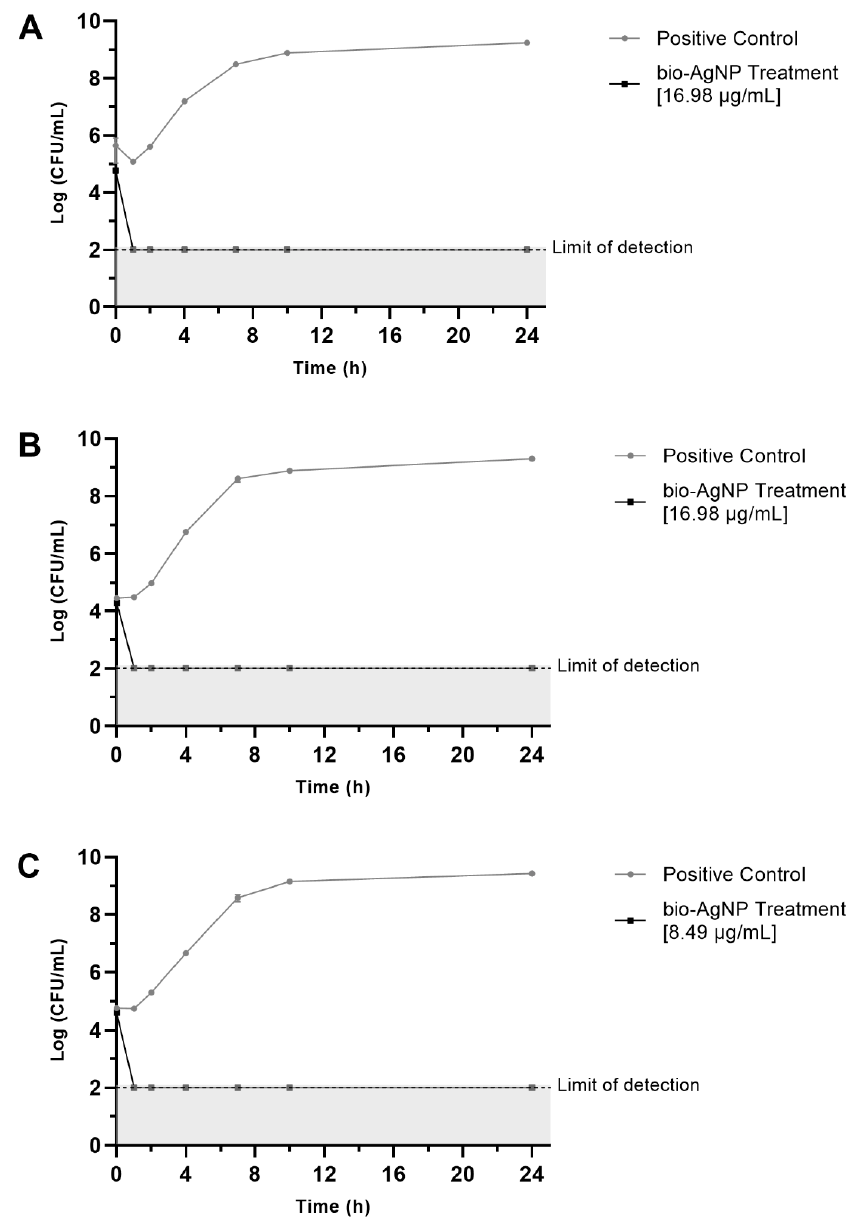
Figure 2. Time-kill curves of bacteria exposed to bio-AgNPs. Positive Control indicates bacterial growth without bio-AgNPs. The data are expressed as the mean ± standard deviation of three repli- cates. ( A ) S. Enteritidis ATCC 13076, ( B ) S . Typhimurium UK-1 ATCC 68169, and ( C ) S. Typhimurium ATCC 13311.